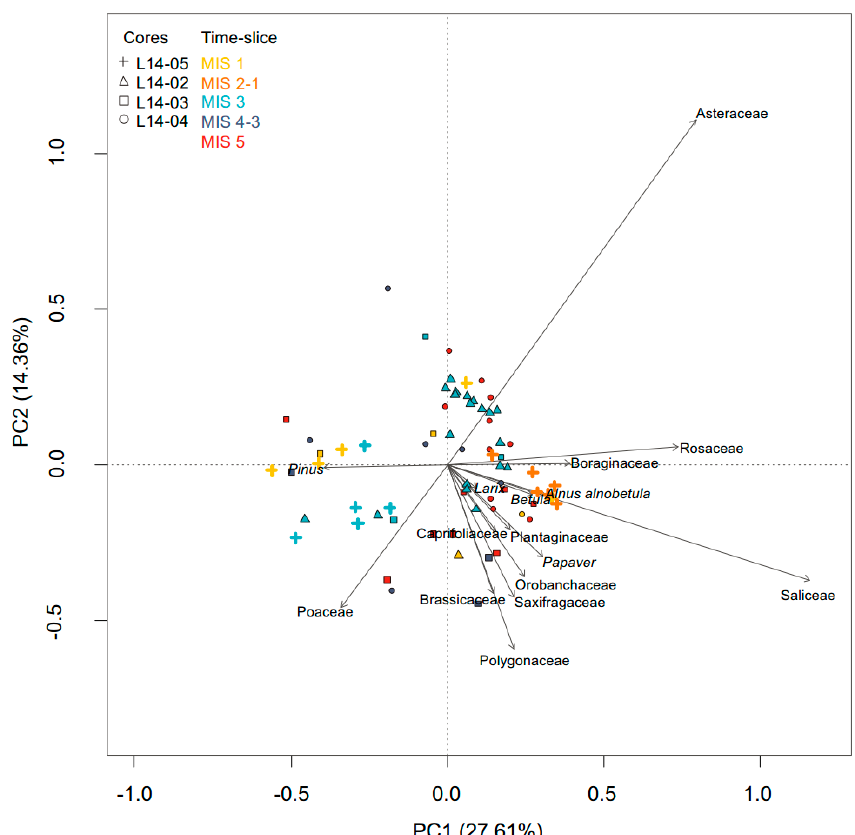
Figure 5. Principal Components Analysis (PCA) biplot comprising the 15 ‐ principal terrestrial sedaDNA taxa (with herbs and non ‐ erect dwarf ‐ shrubs at family level) and Larix . Samples are coloured according to the corresponding marine isotope stage (MIS 1 in yellow, MIS 2 to MIS 1 transition in orange, MIS 3 in light blue, MIS 4 to MIS 3 in dark blue and MIS 5 in red) and the different symbols indicate the core from which the samples were taken (L14–05 with a cross, L14–02 a triangle, L14–03 a quadrate and L14–04 a circle).